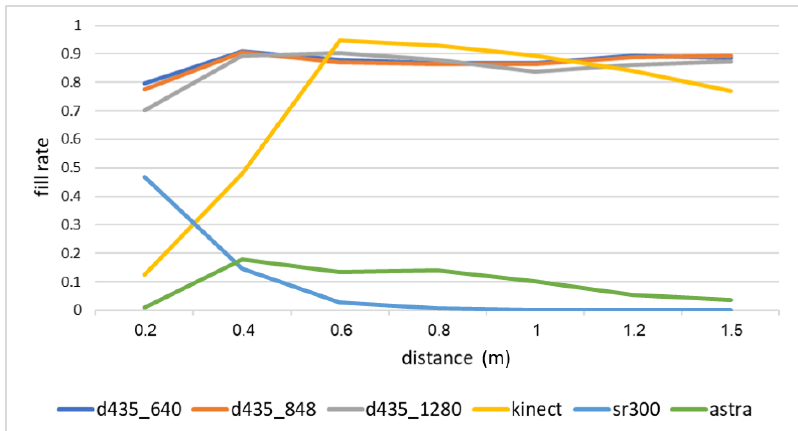
Figure 3. Mean fill rate over all objects of interest for each camera by distance to the objects.